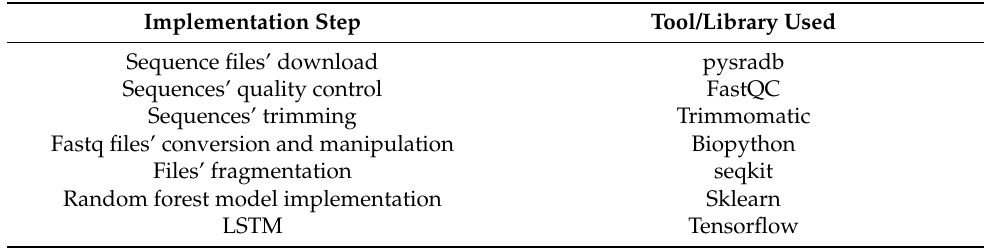
Table 3. Libraries used in the